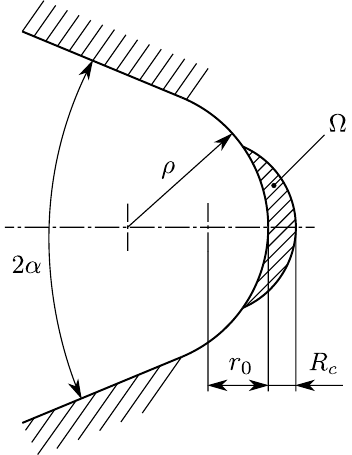
Figure 1. Control volume Ω of a blunt